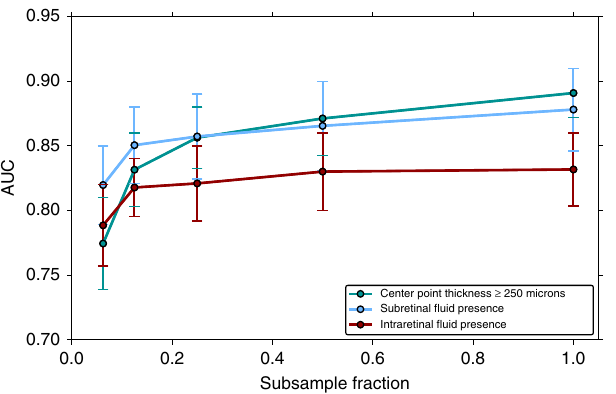
Fig. 3 Effect of data size on prediction performance on the primary clinical validation set. A subsampled fraction of 1.0 indicates the entire training dataset. Model performance continues to increase with increased data, suggesting that the accuracy of predicting ci-DME, subretinal fl uid, and intraretinal fl uid presence will likely improve if the model is trained with more data. Error bars are 95% con fi dence interval using n = 2000 samples with replacement.